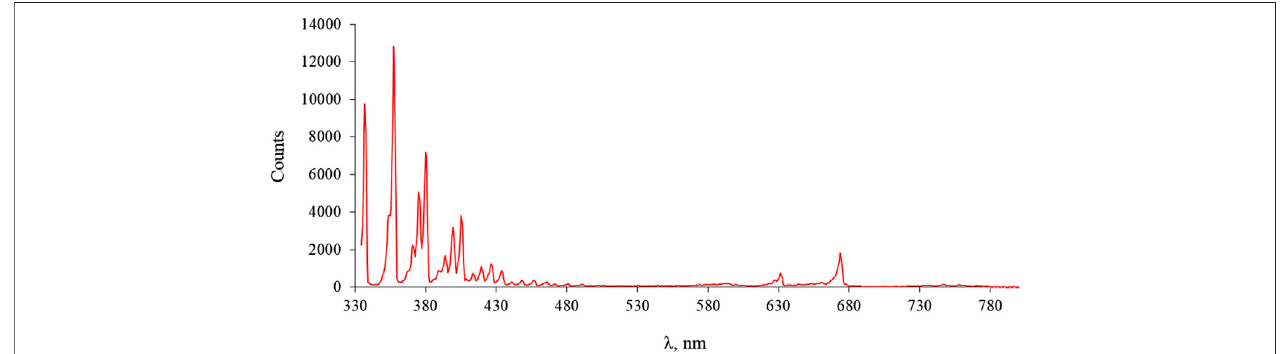
FIGURE 5 | The direct piezo-discharge emission spectrum in the atmosphere under normal conditions.